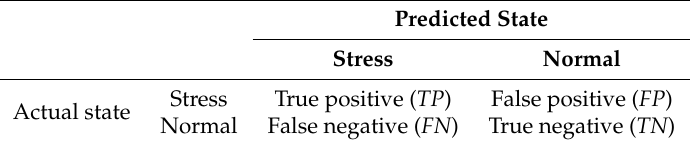
Table 4. Confusion matrix of instances in terms of predicted and actual states: stress and